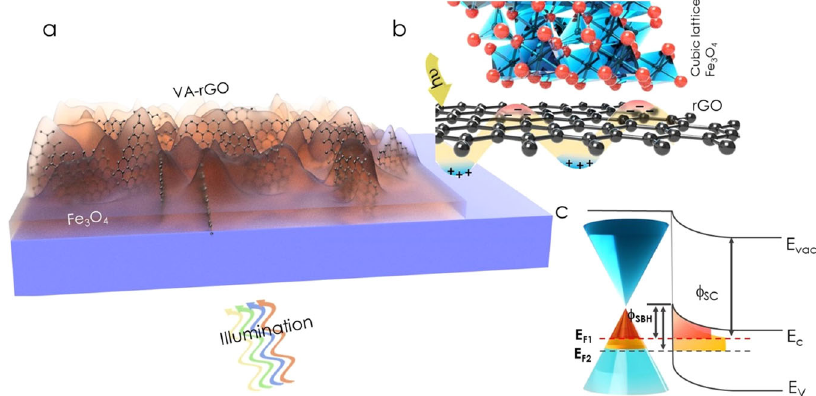
Fig. 1 Overview of the morphology correspondence to local band structure. a Schematic illustration of the vertically aligned rGO scaffolds embedded in Fe 3 O 4 thin- fi lm. b Carrier transfer inbetween rGO sheets and that of Fe 3 O 4 semiconductor. c The band-energy diagram of the hybrid system confers barrier variable charactristic of the SC/graphene junction. The variation of the Fermi level position in rGO energy band as a result of the carrier